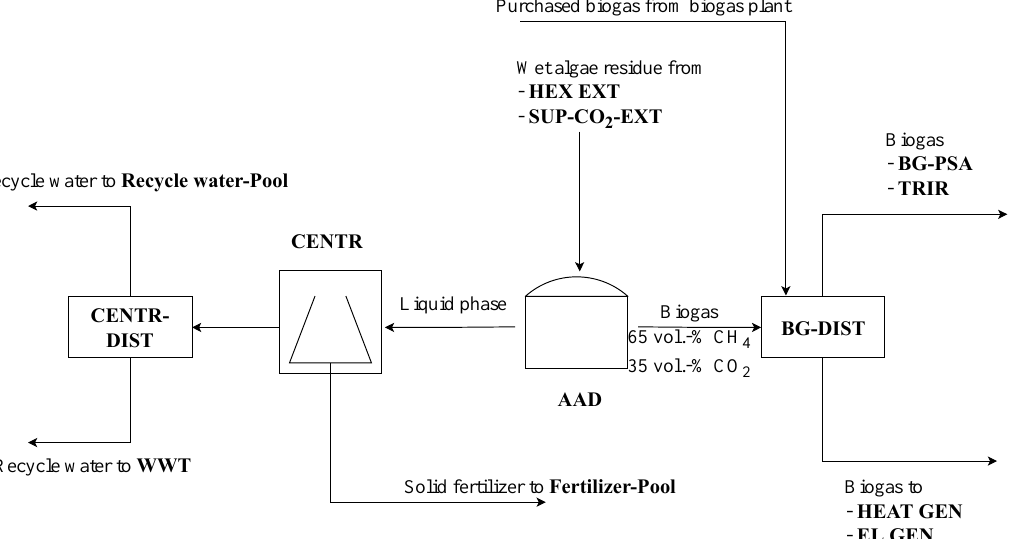
Figure 6. Algae residue treatment process section of renewable refinery superstructure.